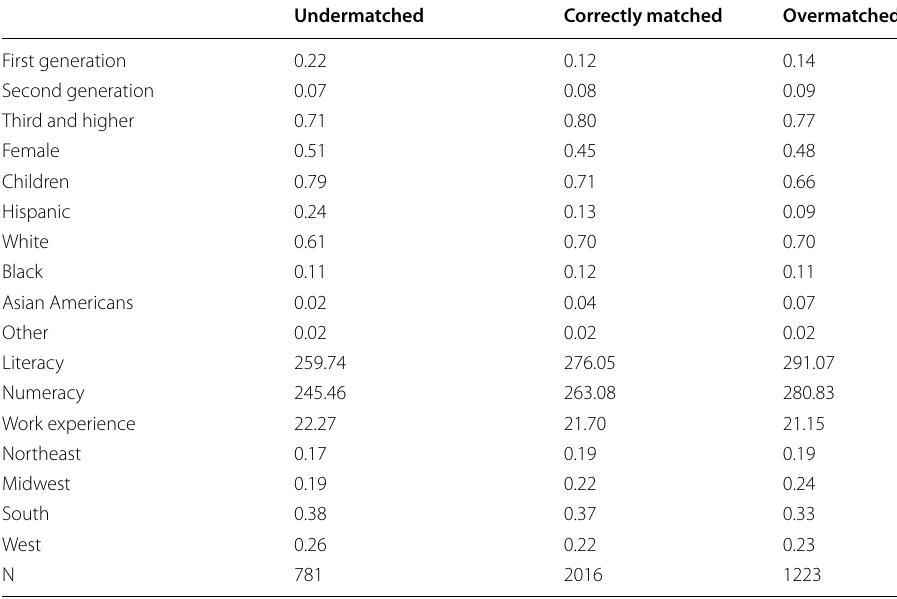
Table 9 Distribution of Selected Independent Variables within Each Job-Education Mismatch Category, All Workers, PIAAC